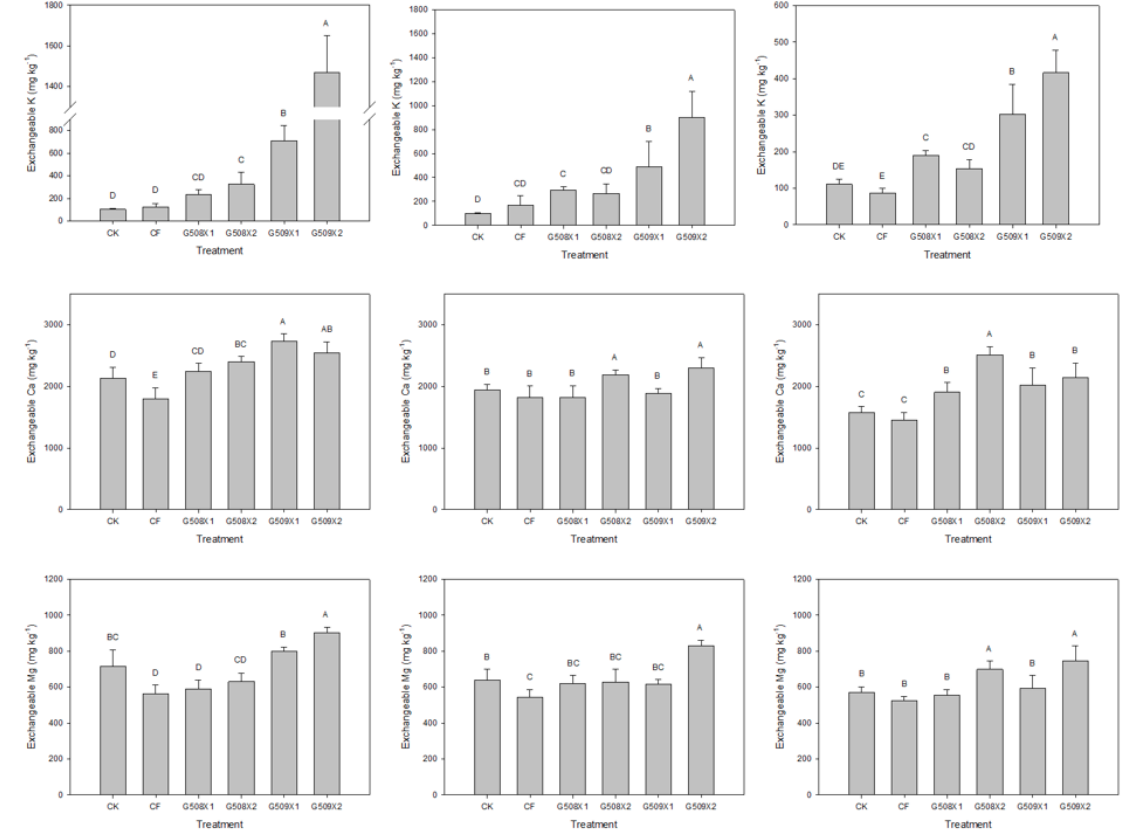
Figure 4. The contents of exchangeable K, exchangeable Ca, and exchangeable Mg in the soil after the field experiment under different treatments for cabbage ( left ), Chinese cabbage ( middle ), and water spinach ( right ). The different letters indicate the significance among the treatments obtained through one-way ANOVA analysis (Duncan test, p < 0.05, n = 4). The codes have the same meanings as those in Figure 1.